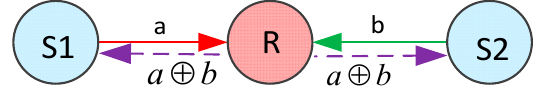
Figure 1. A three-node chain topology of network